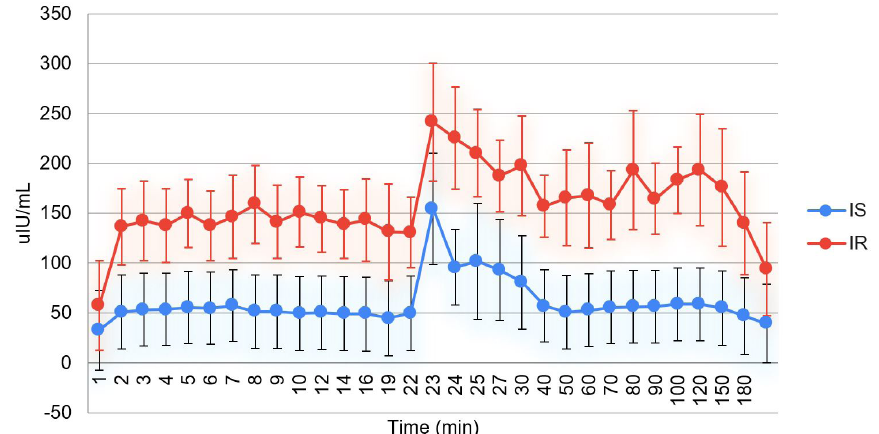
Figure 2. Plasma insulin mean and 95%CI in insulin resistant (IR) and insulin sensitive (IS) horses during the